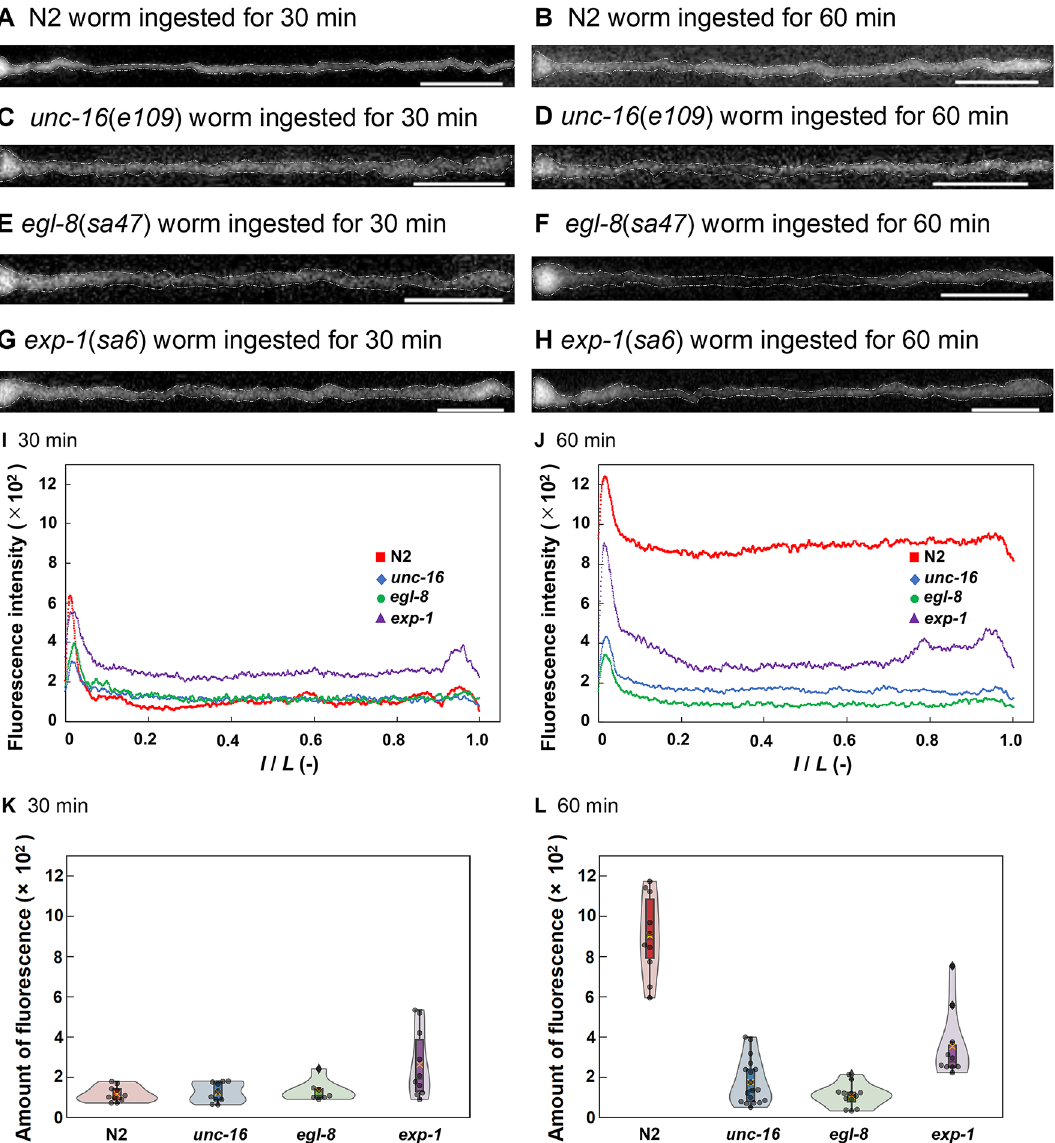
Figure 2. Distributions of fluorescent glucose in the intestine at 30 and 60 min. ( A-H ) Fluorescence micrographs of C. elegans intestine containing a 0.13% (v/v) suspension of OP50-1 labeled with fluorescent glucose. Left and right edges indicate entrance and exit, respectively, of the intestine. Scale bars, 100 µm. ( A ) N2 at 30 min. Broken line shows the outline of the intestine. ( B ) N2 at 60 min. ( C ) unc-16 ( e109 ) at 30 min. ( D ) unc- 16 ( e109 ) at 60 min. ( E ) egl-8 ( sa47 ) at 30 min. ( F ) egl-8 ( sa47 ) at 60 min. ( G ) exp-1 ( sa6 ) at 30 min. ( H ) exp-1 ( sa6 ) at 60 min. ( I, J ) Distributions of 0.13% (v/v) OP50-1 labeled with fluorescent glucose in the intestine at 30 and 60 min. Colored dots show mean values. Vertical axis represents glucose fluorescence intensity in intestinal cells. l/L shows the position from the edge of the anterior part of the intestine divided by the length of the intestine. ( I ) 30 min; n ≥ 7 (each strain). ( J ) 60 min; n ≥ 7 (each strain). ( K, L ) Violin plots of glucose uptake per unit length of intestine. ( K ) 30 min. n ≥ 7 (each strain). ( L ) 60 min. n ≥ 7 (each strain). Data points and a box plot are shown in each violin plot. Cross plots and center lines in the box plots denote mean and median values,